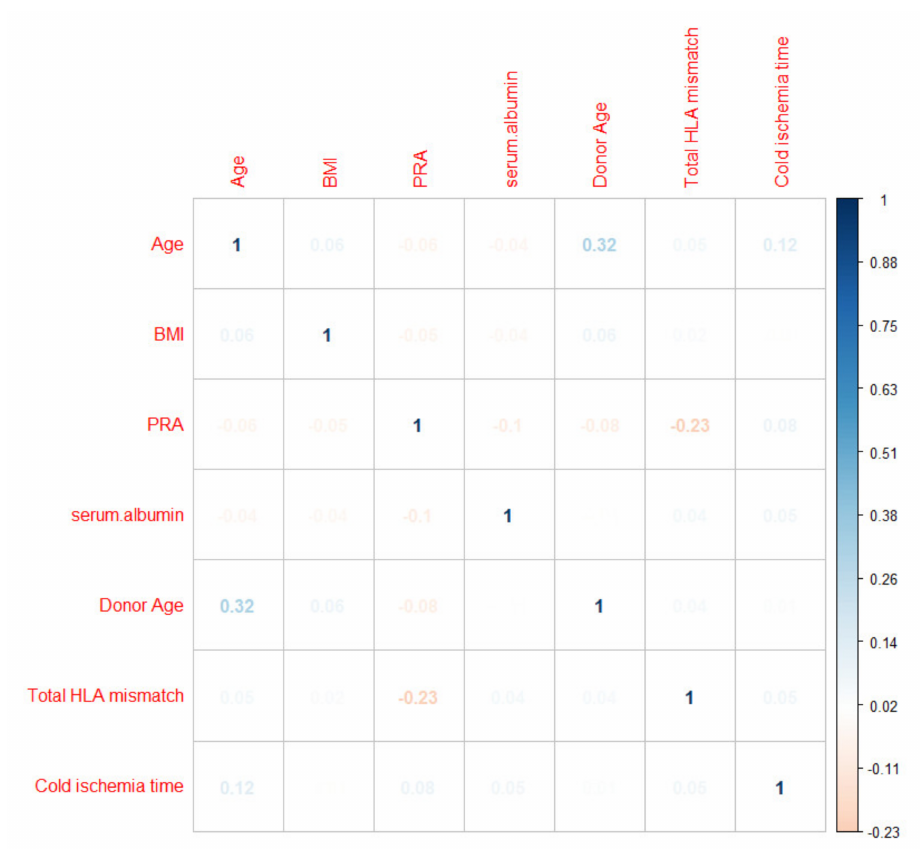
Figure 1. Correlation matrix assessing the pair-wise correlation between the continuous variables. Using traditional analysis with backward stepwise multivariable logistic regression (Table 2), the independent predictors for increased acute rejection risk included kidney retransplantion, dialysis duration ≥ 1 years, a PRA of 81–100, HIV infection, ECD deceased donor utilization, a higher total number of HLA mismatches, delayed graft function, basiliximab induction, and the use of cyclosporine, azathioprine, and mTOR inhibitors for maintenance immunosuppression. In contrast, the independent predictors for decreased rejection risk included older recipient age and the use of thymoglobulin and alemtuzumab for